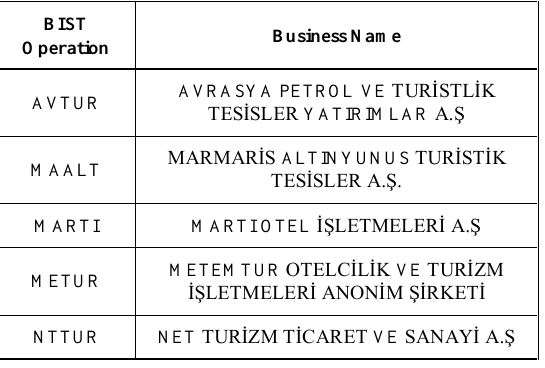
Table 2: Businesses Operating in the Tourism Sector (BIST) BIST